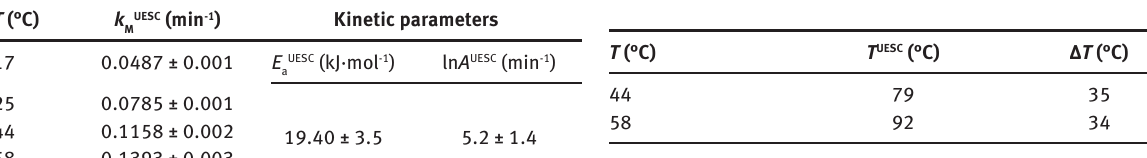
Table 1: The model rate constant and kinetic parameters of caffeine extraction under the UESC. Table 2: The values of hypothetical temperature in the reaction